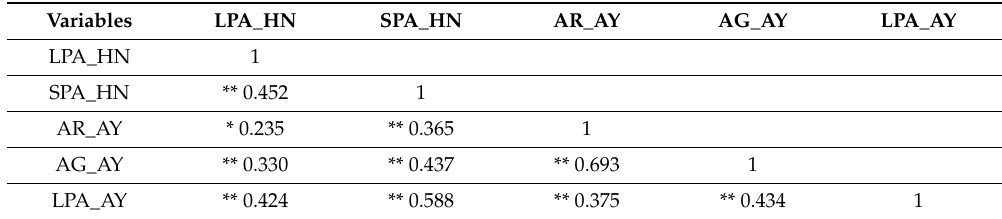
Table 2. Correlations between leaf and stem pubescence among 224 individuals with aphid population across two locations.